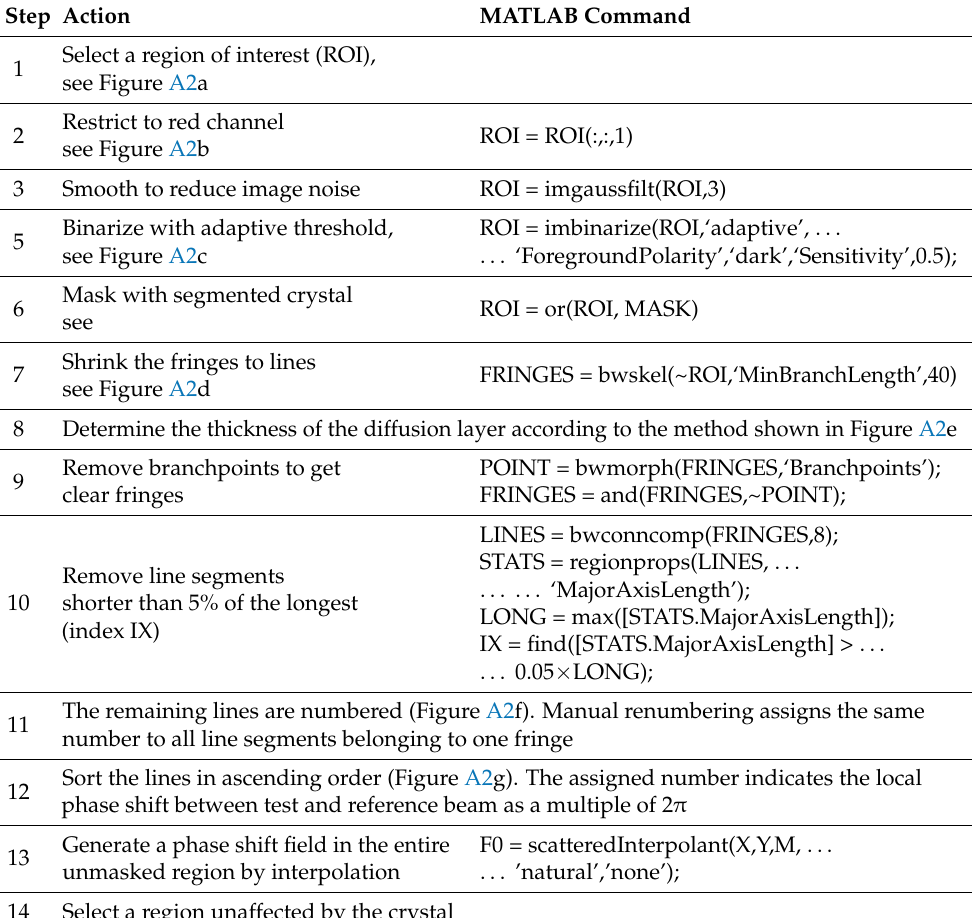
Table A4. Image processing procedure for the determination of the concentration